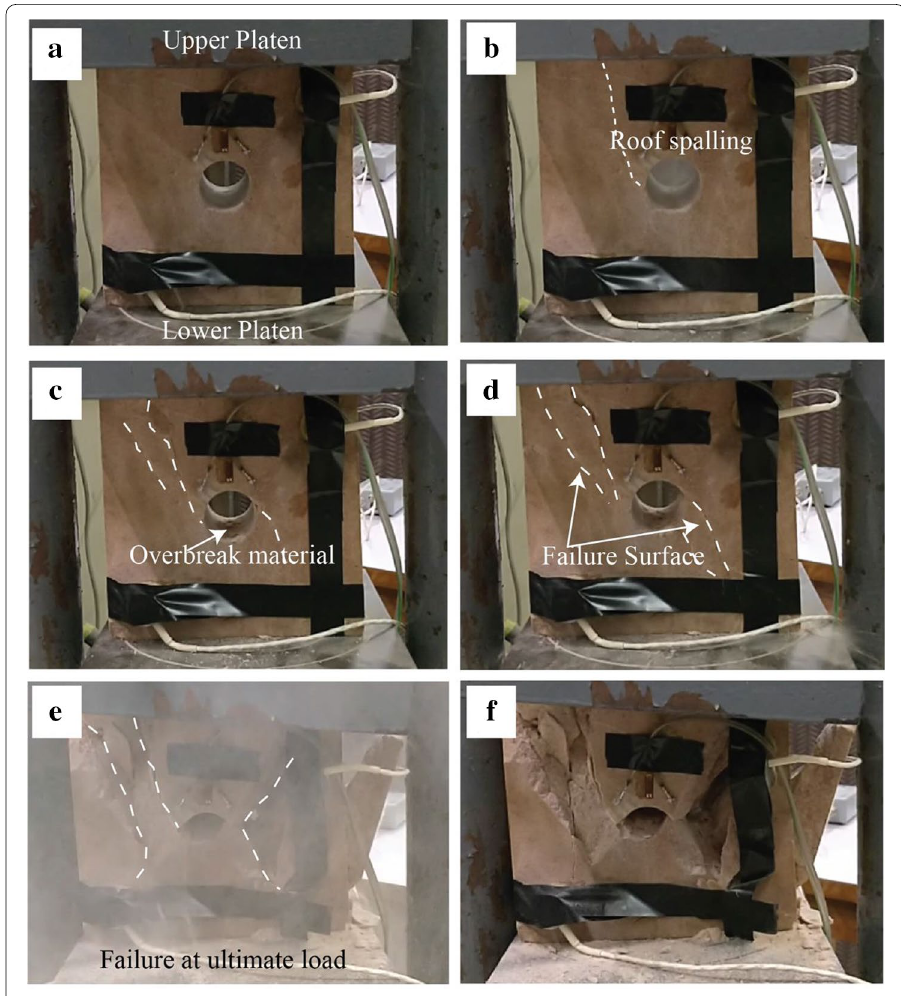
Fig. 6 Failure in intact sandstone block with a circular opening, as the load is applied following failure pattern results starting from ( a – f ). a Initial equilibrium, no-load acting on the block, ( b ) Between 20–25% of the failure load, spalling occurs from the tunnel roof and a crack development is started on the left wall, ( c, d ) overbreak is visible and on both the sidewall crack is starting propagating, ( e , f ) the block is failed at